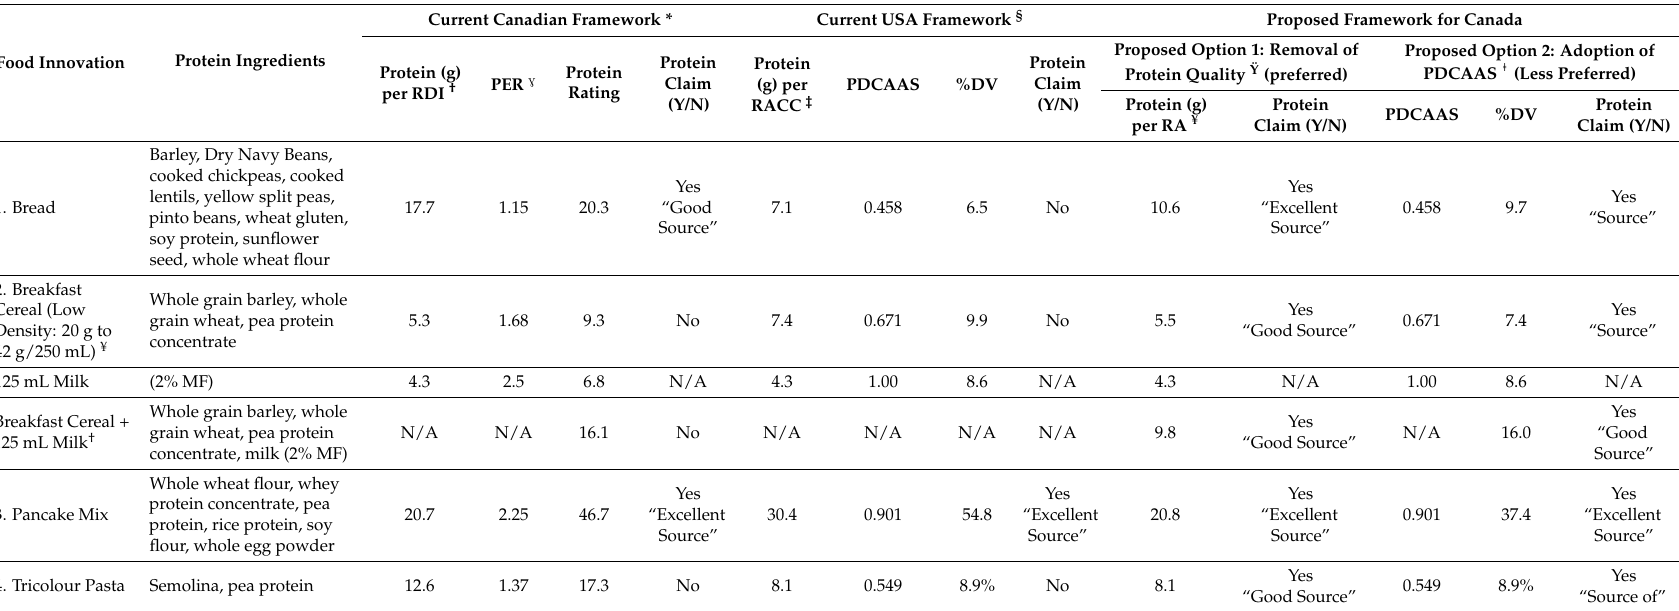
Table 5. Summary and application of current and proposed regulatory frameworks for protein content claims for four existing foods recently reformulated to include increased levels of plant-based